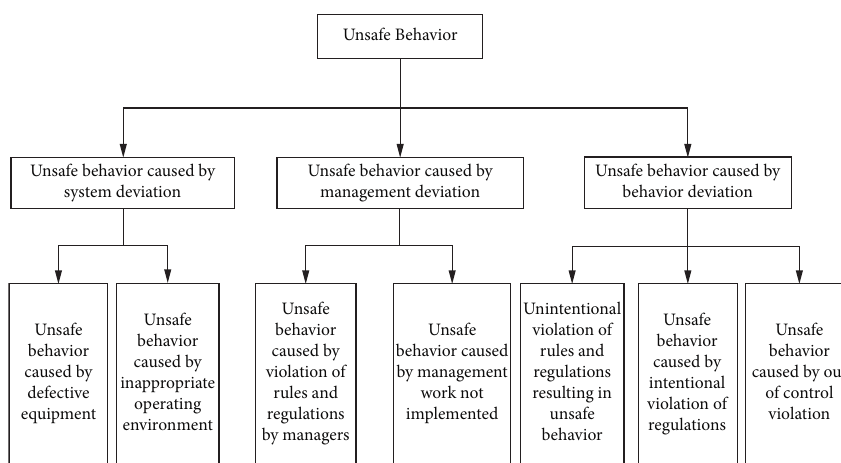
Figure 2: Classification of unsafe behaviors. Table 1: Data on miners’ unsafe behavior in the fourth quarter of